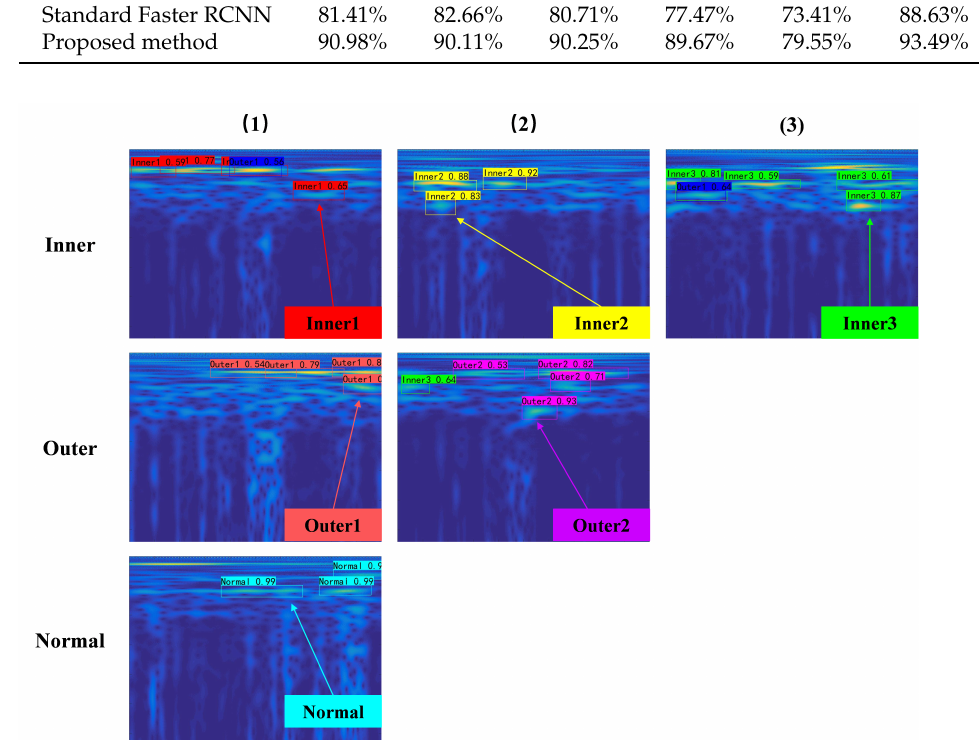
Figure 15. Data samples and their corresponding detection results in realistic damages (ResNet50 with